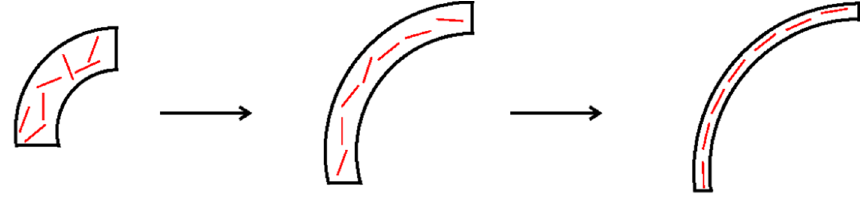
Figure 6. The arrangement of nanoparticles in the bubble wall.